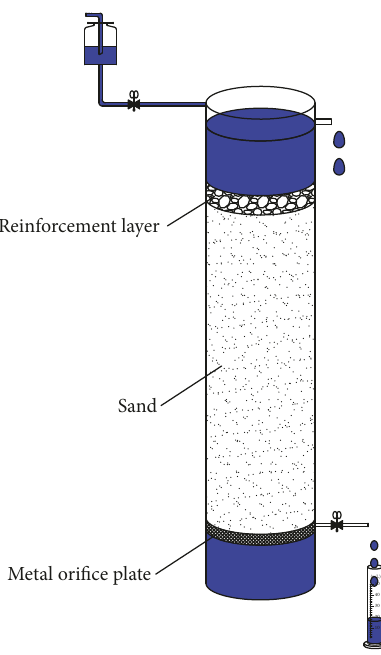
Figure 3: The soil penetrant used in penetration test.